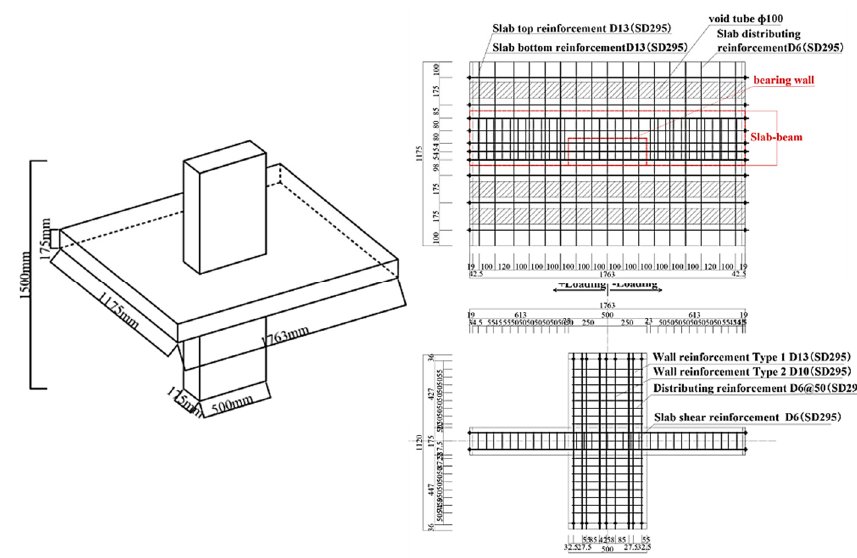
Figure 7. Plan view and configuration [11,12].